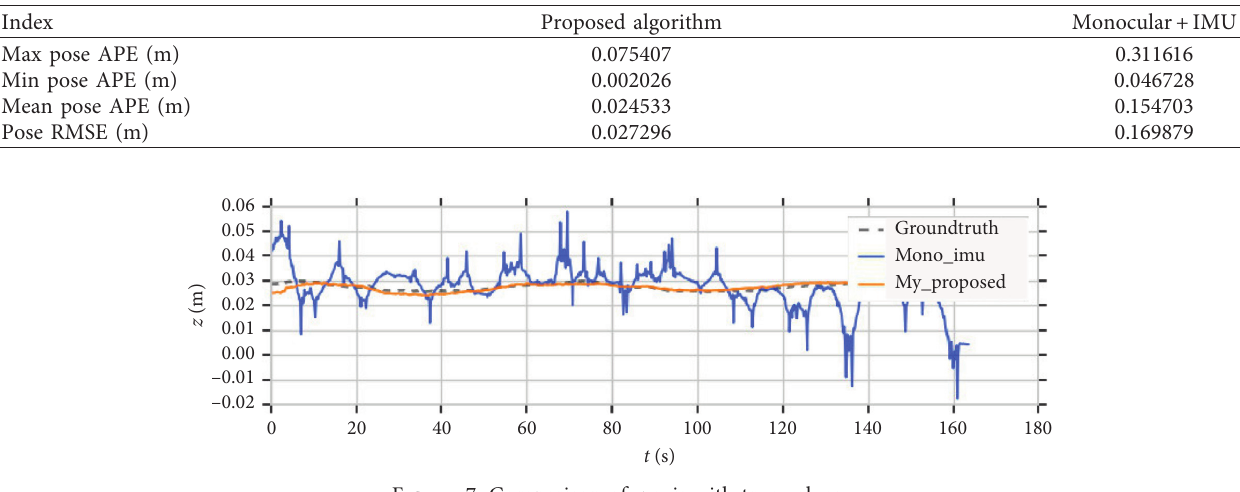
Figure 6: Pose APE comparison of the two methods. Table 2: APE statistics results of two methods.